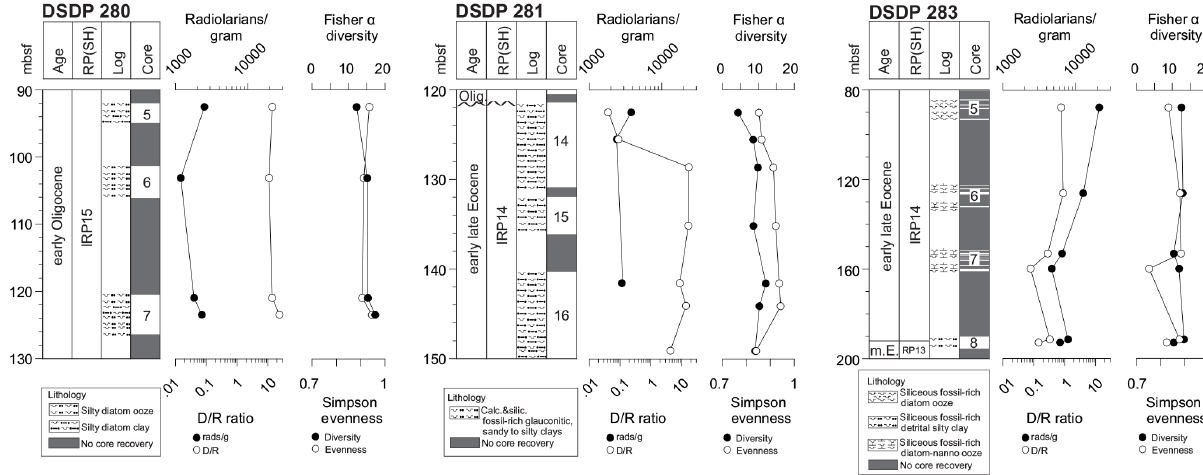
Figure 5. Stratigraphy, Southern Hemisphere radiolarian zones (RP), lithology and core recovery at DSDP sites 280, 281 and 283. Variation in radiolarian abundance, diatom/radiolarian (D / R) ratio, Fisher α index and Simpson evenness for radiolarian assemblages at all